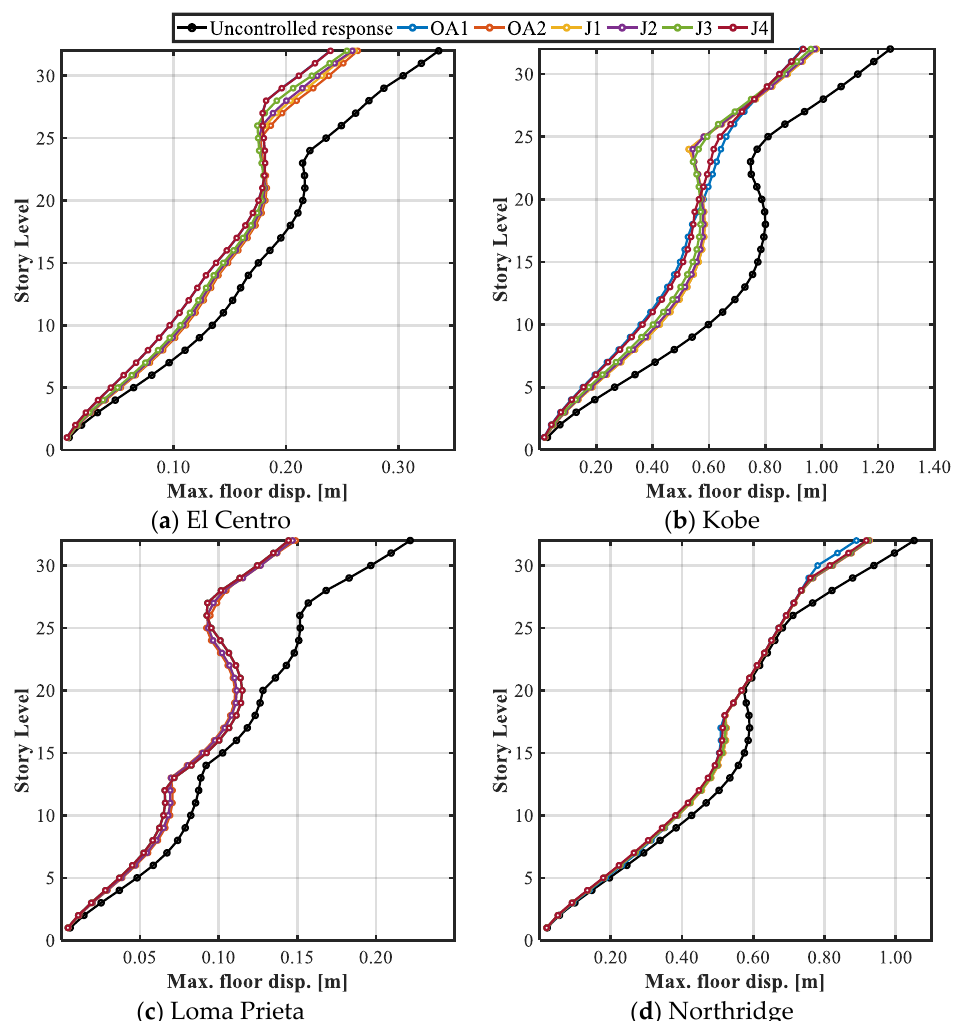
Figure 8. Maximum floor displacement at each story level of the structure equipped with TMDs with µ =